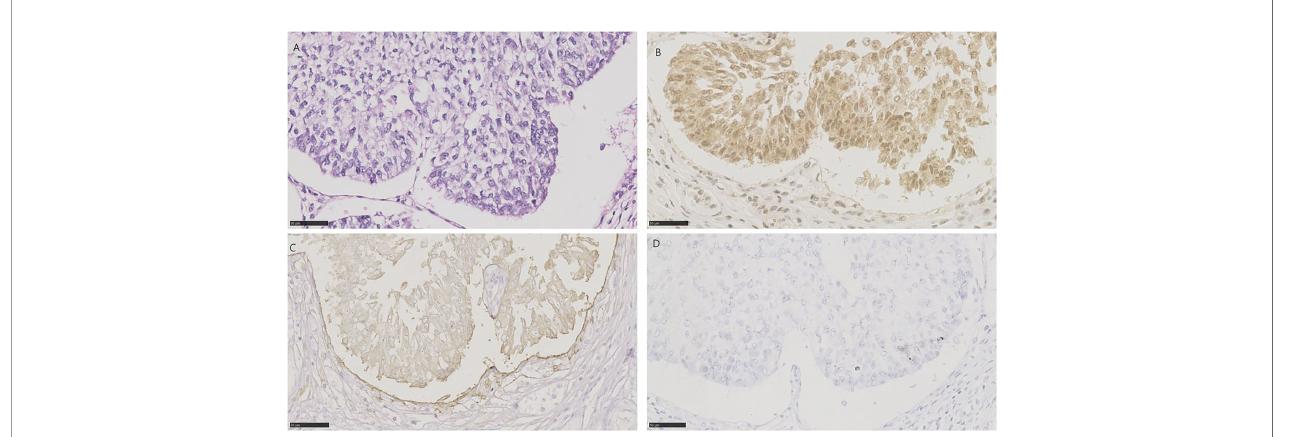
FIGURE 5 | HE and immunohistochemistry for NECTIN-4, TROP-2, and HER2 in nested urothelial carcinoma. Scale bar: 50 µm. (A) HE-stained section of nested urothelial carcinoma. (B) Immunohistochemistry for NECTIN-4 in the same tumor showing strong staining. (C) Immunohistochemistry for TROP-2 in the same tumor showing moderate staining. (D) Immunohistochemistry for HER2 in the same tumor showing